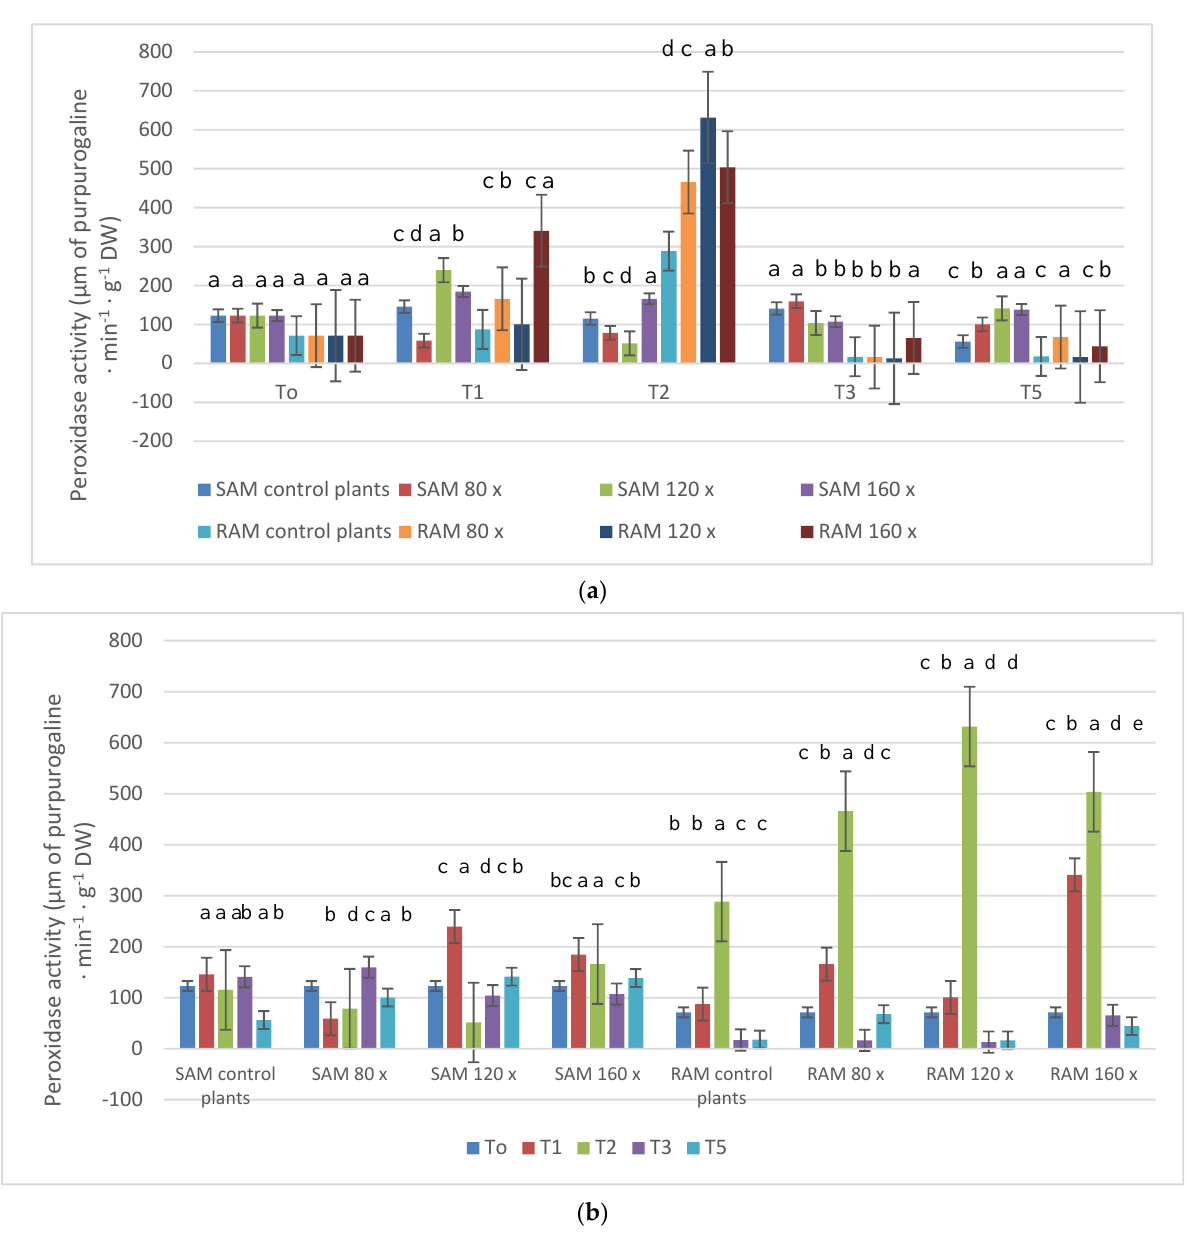
Figure 5. ( a ) POX activity (µg purpurogallin·g −1 DW) in the apical meristem of stems [SAM] and roots [RAM] of petunias subjected to MS depending on stress intensity. The specimen was collected from 15 plants from each treatment in each of the five terms; α − 0.05. ( b ) POX activity (µg purpurogallin·g −1 DW) in the apical meristem of stems [SAM] and roots [RAM] of petunias subjected to MS depending on stress duration. The specimen was collected from 15 plants from each treatment in each of the five terms; α − 0.05 The lowercase letters present statistical differences (α − 0.05) between the treatments..